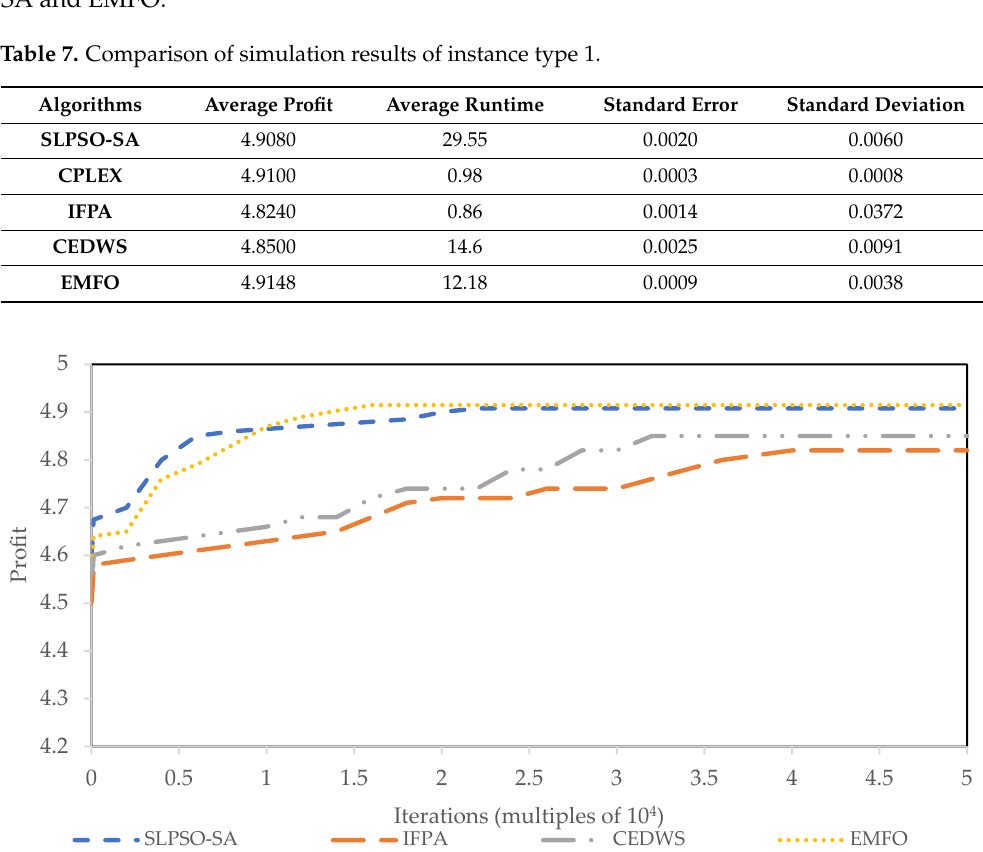
Figure 2. Convergence characteristics of algorithms for instance type 1.